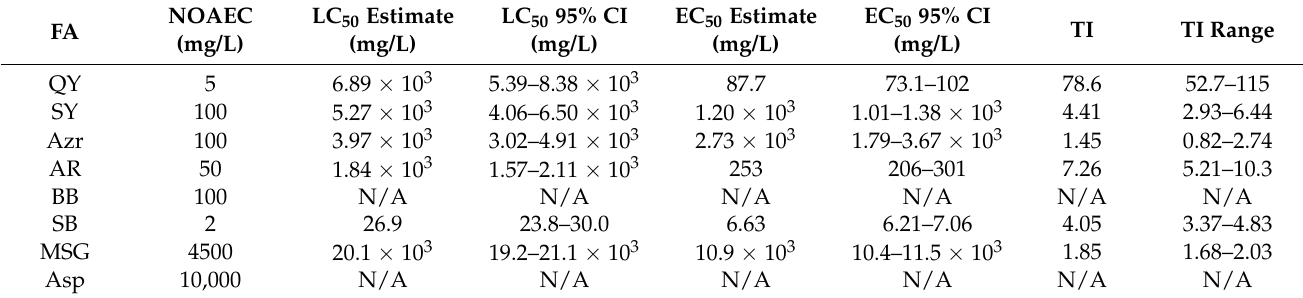
Table 2. Toxicological indices of the tested food additives.